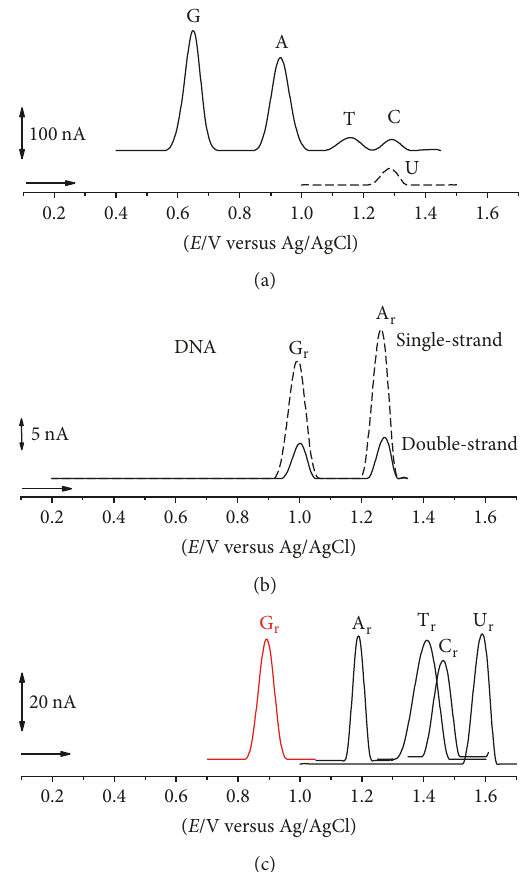
Figure 1: DP voltammograms baseline corrected at a GC electrode, solutions of ((a) black solid line) 20 𝜇 M guanine (G), adenine (A), thymine (T), and cytosine (C); ((a) black dashed line) 20 𝜇 M uracil (U) in pH 7.4; (b) 60 𝜇 g mL −1 DNA (black solid line) double-strand and (black dashed line) single-strand in pH 4.5; ((c) red solid line) 40 𝜇 g mL −1 poly(dG); ((c) black solid line) 40 𝜇 g mL −1 poly(dA), 100 𝜇 gmL −1 poly(dT), 100 𝜇 g mL −1 poly(dC), and 250 𝜇 gmL −1 poly(dU) in pH 7.4. [Adapted from [48, 49] with